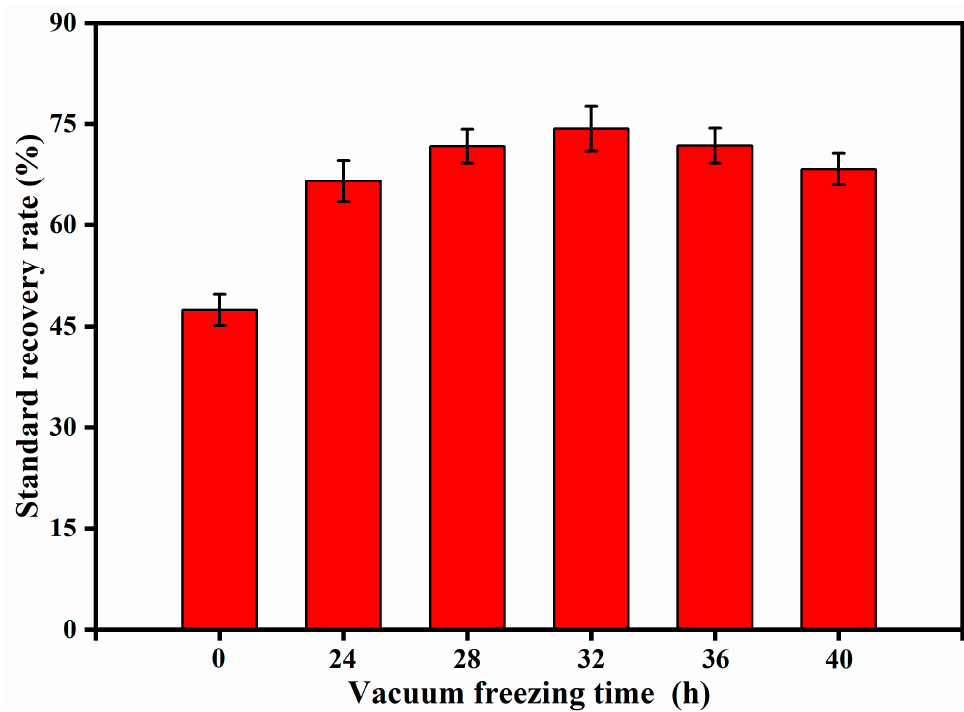
Figure 5. The influence of different vacuum freezing times on the aniline matrix spike recovery rate.